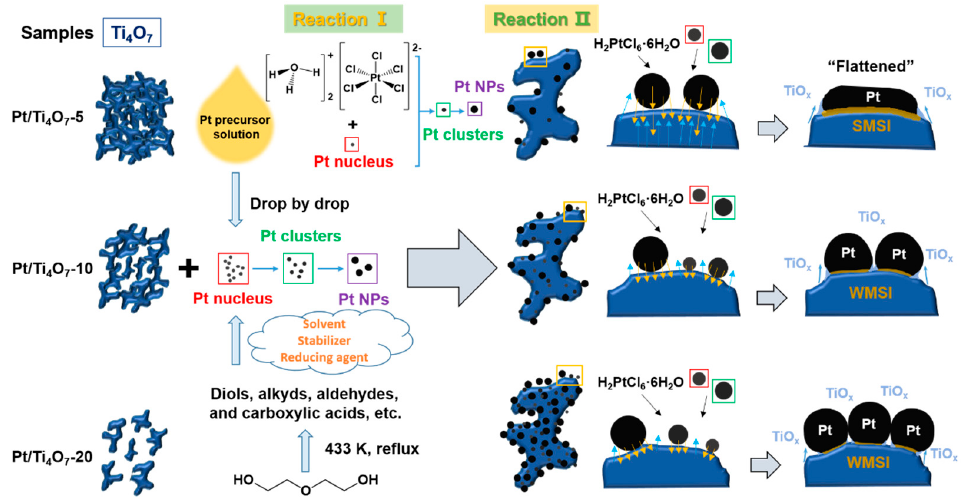
Figure 5. Proposed mechanism diagram according to morphologies and crystalline structure anal-